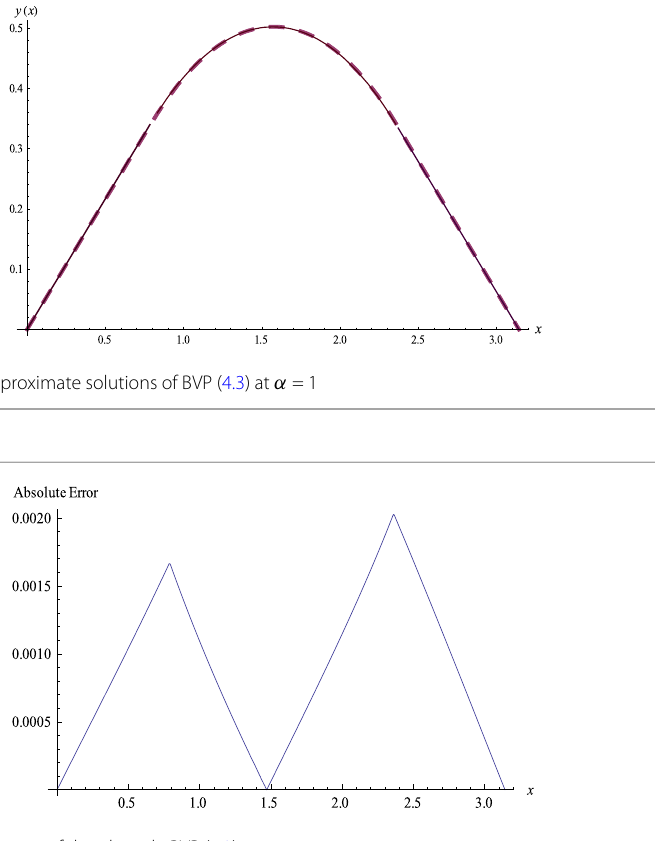
Figure 2 Absolute errors of the obstacle BVP (4.3) at α = 1